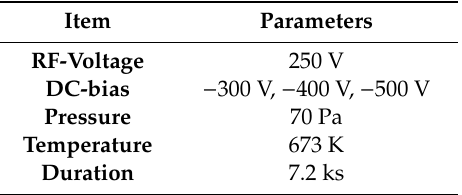
Table 1. High-density plasma nitriding conditions.